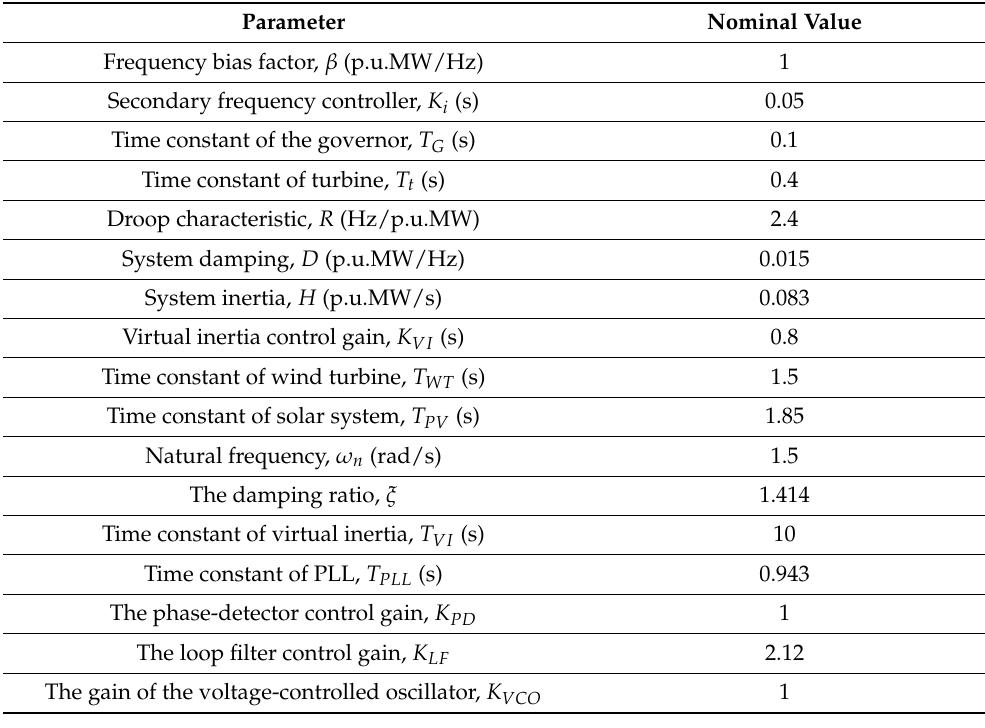
Table 1. Dynamic parameters of the studied microgrid.